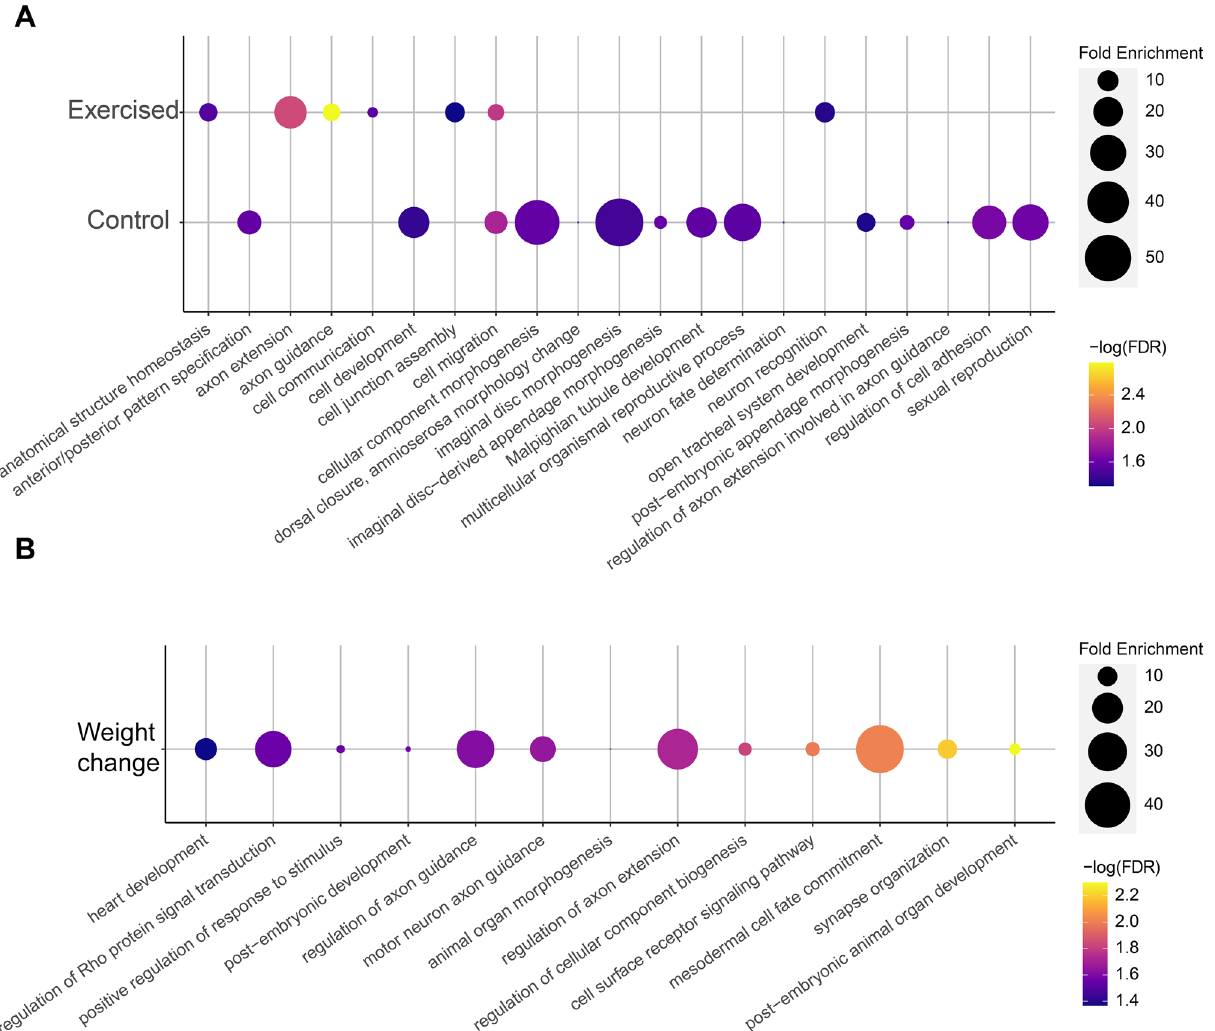
Figure 4. GO term analysis suggests a link between body weight and the CNS. High level GO terms significantly overrepresented in the gene set identified by the body weight GWAS analyses are shown, with fold enrichment shown by the size of the circles and the p-value (FDR) for the over-representation test (Fisher’s Exact Test) shown by the color of the circles. Top: Data from exercised animal weight analysis; bottom: Data from exercised animal weight analysis.